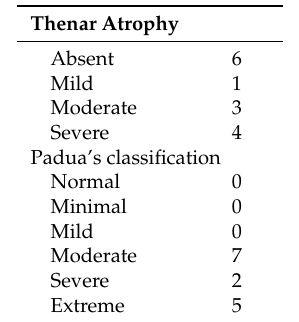
Table 2. Data of physical findings and NCV in the CTS group (n = 14).